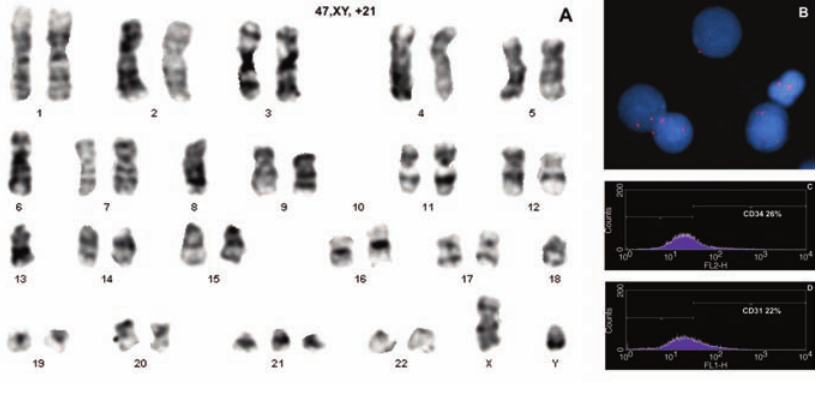
Figure 2. Cytogenetic and flow cytometry analysis of cells harvested from an atrial myx- oma excised from a symptomatic, 75-years old male patient. The GTG-analysis revealed a clonal chromosomal aberration (47, XY, +21) (A), which was confirmed by fluorescence in situ hybridization method (B). Additionally, the phenotype of myxoma cells was ana- lyzed and large populations of hematopoietic progenitor cells – CD34+ (C) and endothe- lial-like cells – CD31+ (D) were